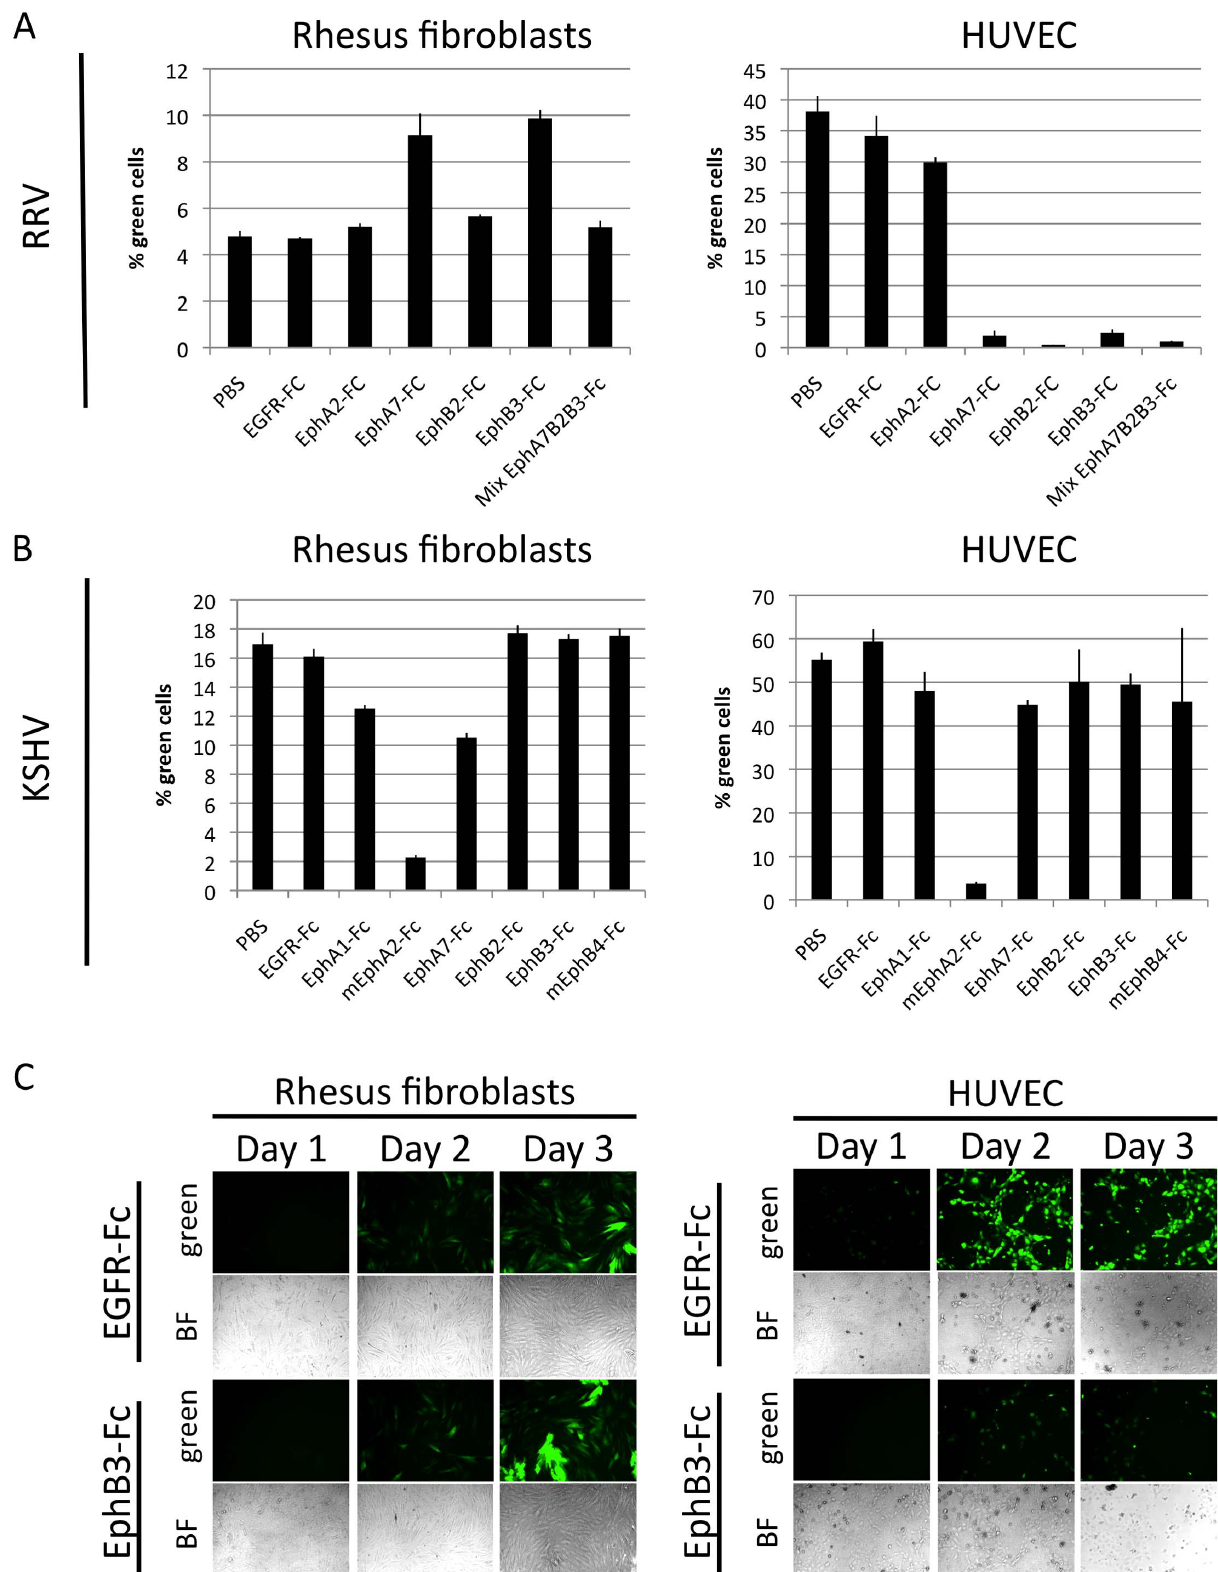
Figure 7. Differential entry of KSHV and RRV into fibroblasts and endothelial cells. ( A ) RRV-GFP 26-95 was pre-incubated with the indicated Eph-Fc fusion proteins at 20 m g/ml or a mix of three at 6.66 m g/ml. The virus was then divided and inoculated onto primary rhesus fibroblasts or HUVEC cells. Entry was quantified by flow cytometry. (n=3; error bars indicate sd) ( B ) KSHV was pre-incubated with the indicated